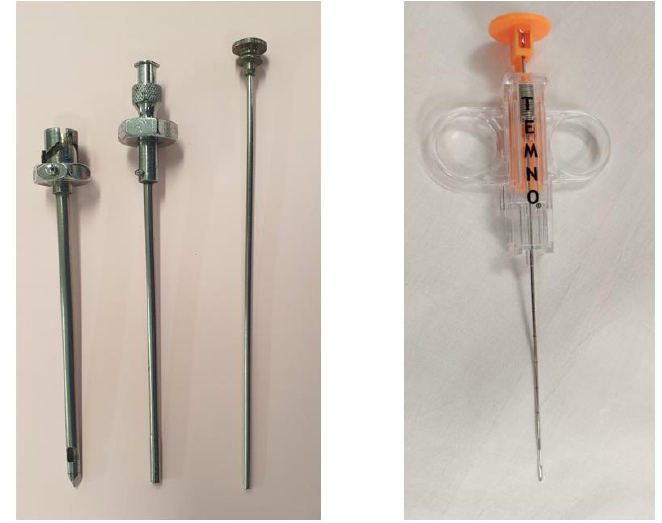
Figure 2. Abrams needles ( left ) and Temno needle ( right ).